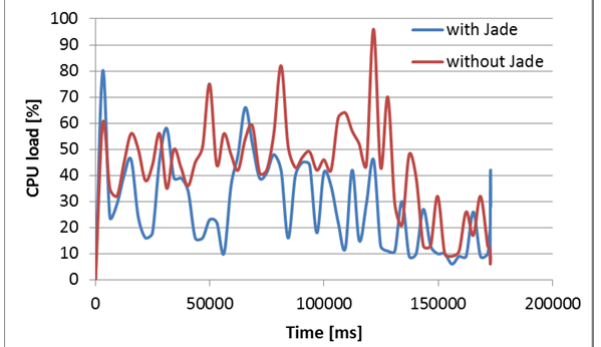
Figure 9: CPU load of